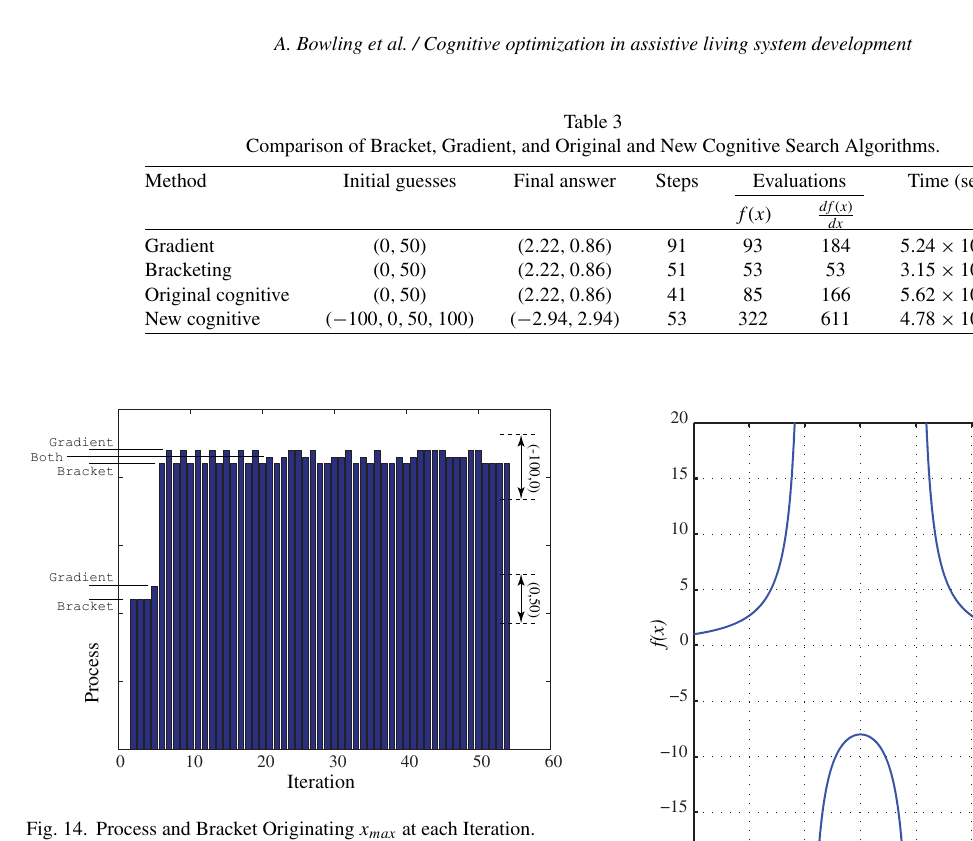
Fig. 14. Process and Bracket Originating x max at each Iteration.